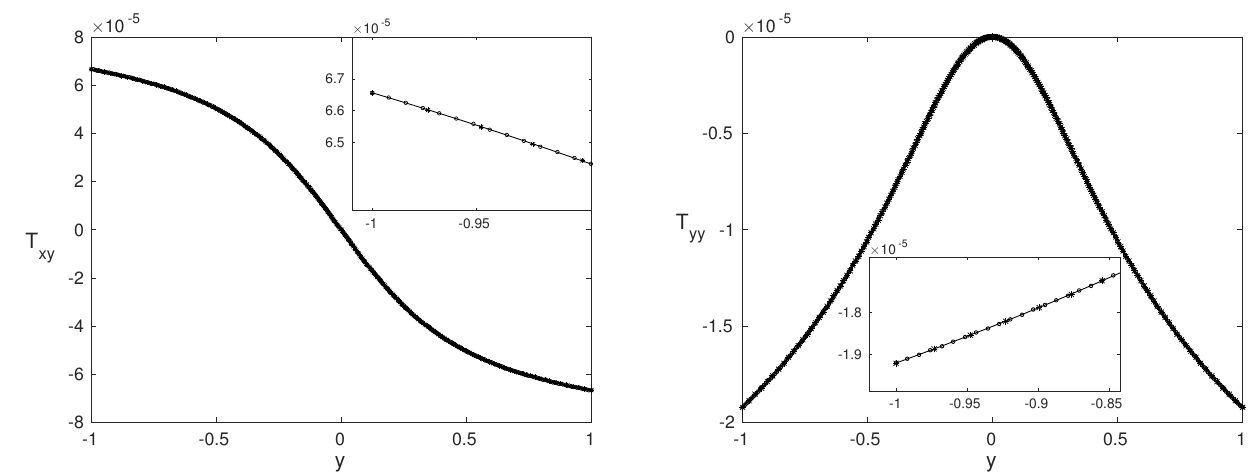
Figure 2. Same as in Figure 1 for dimensionless numbers: Re = 5000, β = 0.5, α G = 0.2 and Wi = 2.